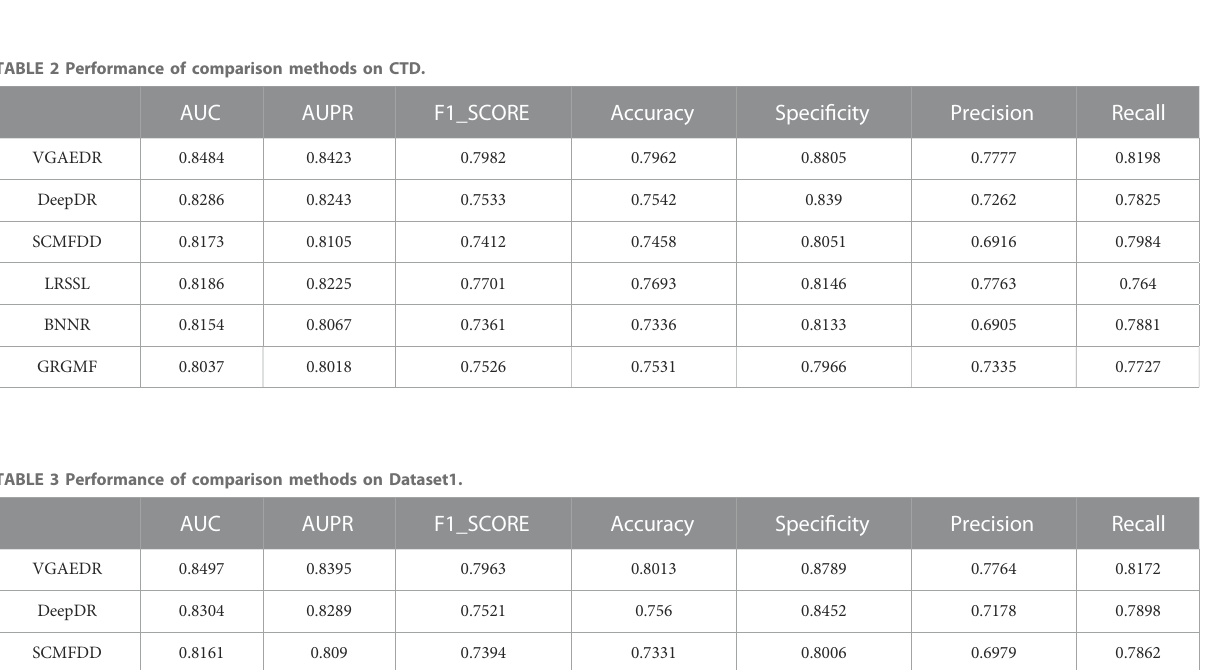
TABLE 2 Performance of comparison methods on CTD.